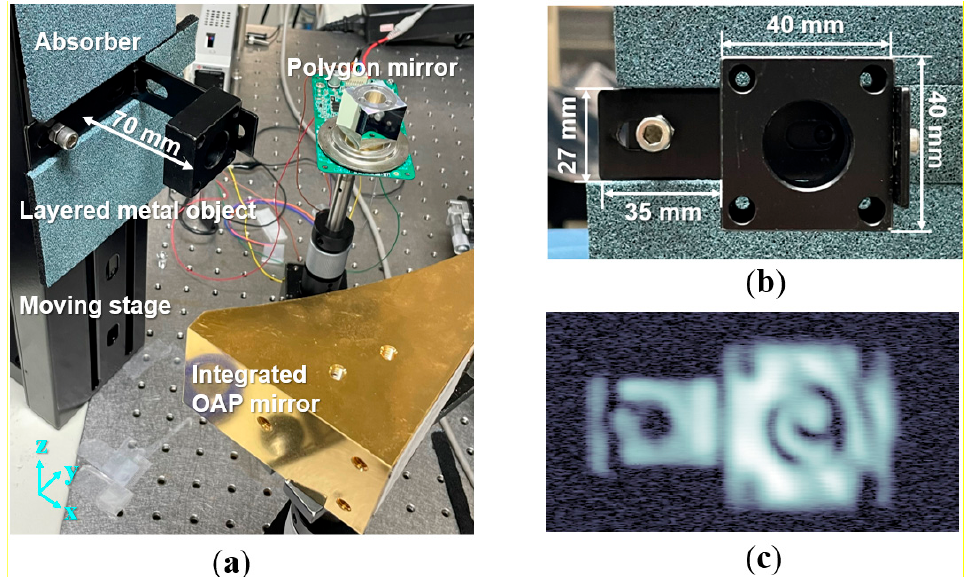
Figure 11. ( a ) Experimental setup for focal depth experiment. ( b ) Front view photograph of the layered metal object. ( c ) Imaging result of the layered metal object.